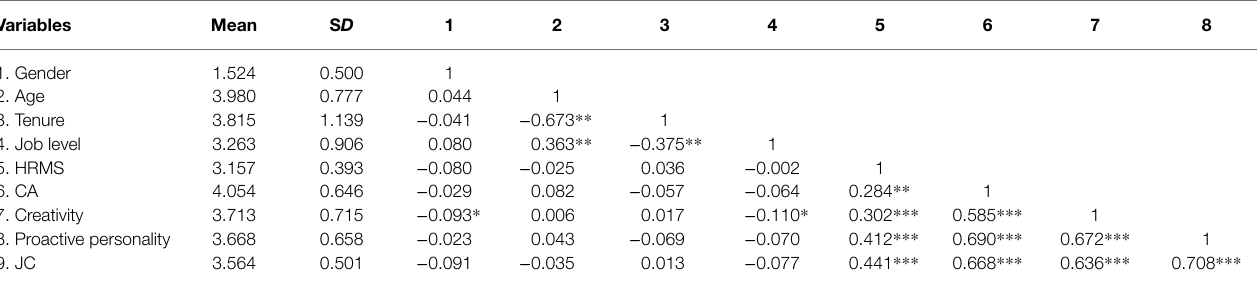
TABLE 6 | Correlation analysis. Variables